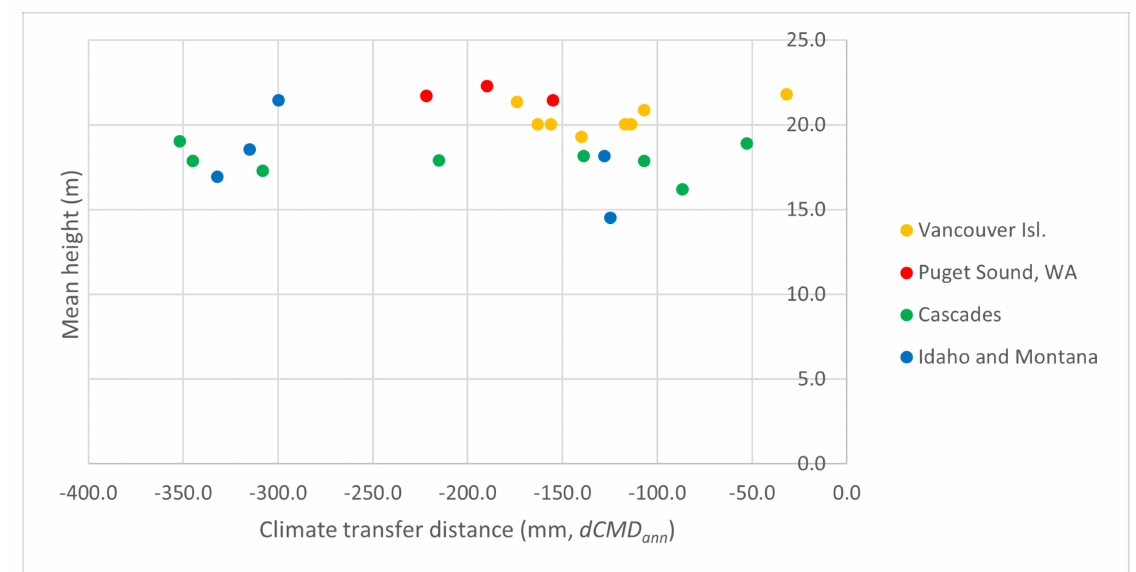
Figure 8. Mean height response of grand fir provenances to climate transfer distance (current vs past) expressed in annual climatic moisture deficit (mm precipitation deficit dCMD ann ), in the trial Zbiroh. Colors indicate origin of populations (see also Figure A2a,b for climatic distances, expressed in temperature and precipitation changes). Note the differentiation by provenance